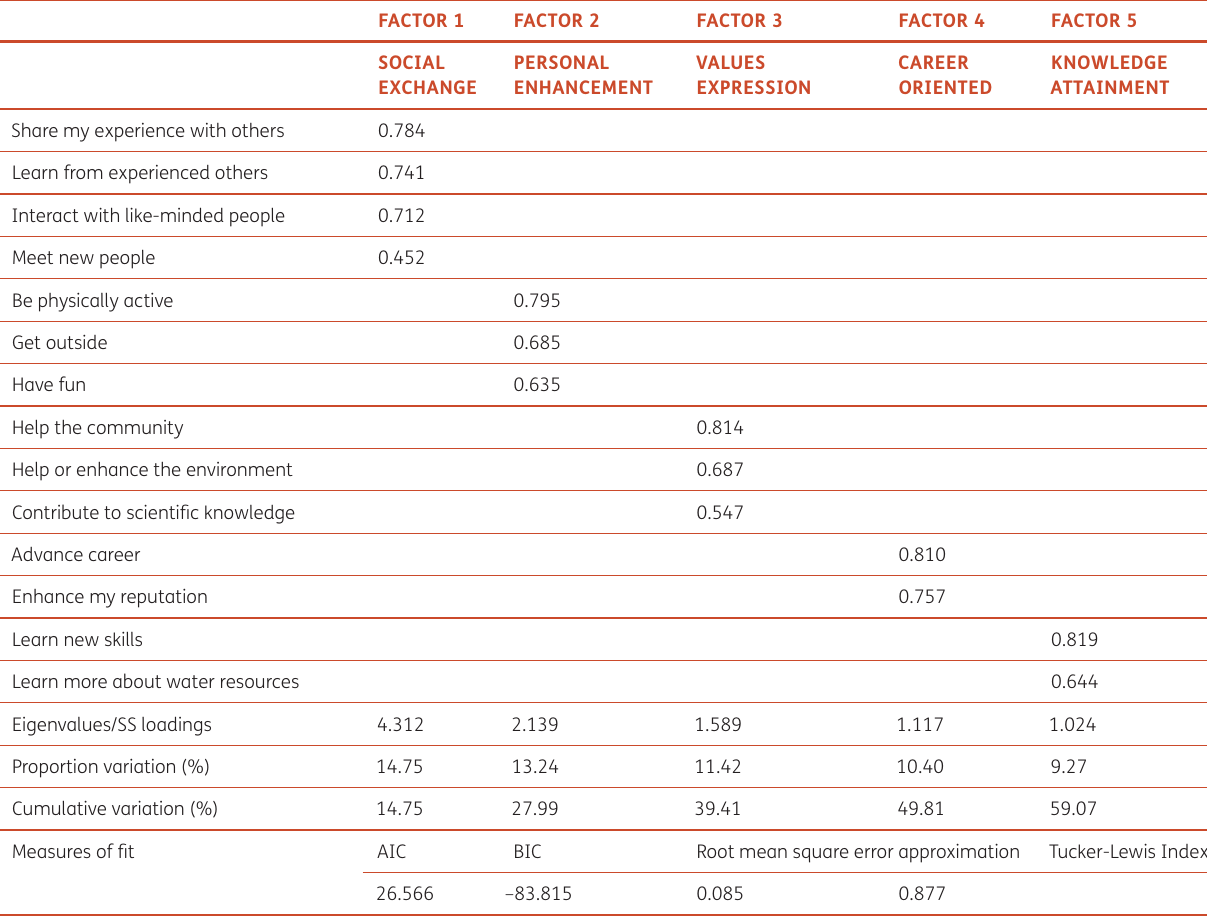
Table 2 Motivation/dispositional variable factor loadings, eigenvalues, variation, and measures of fit. AIC = Akaike information criterion; BIC = Bayesian information